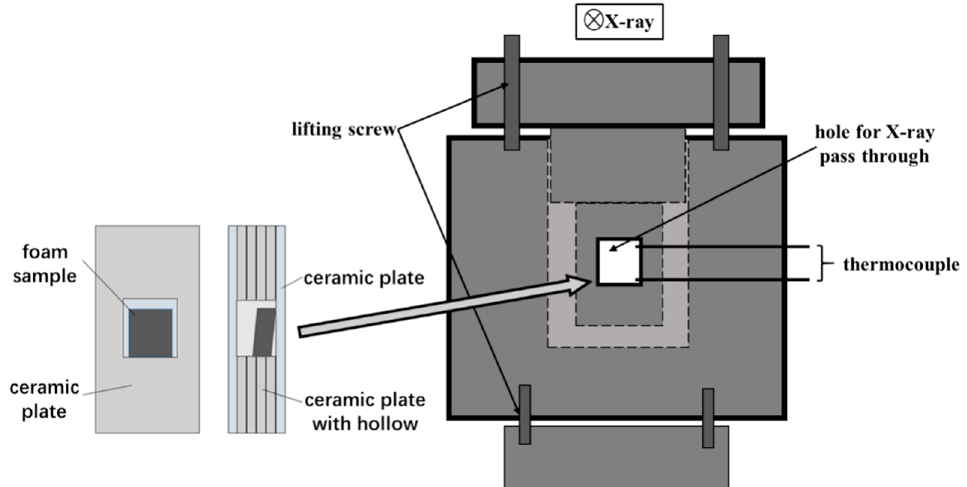
Figure 1. Sketch of the foaming furnace.